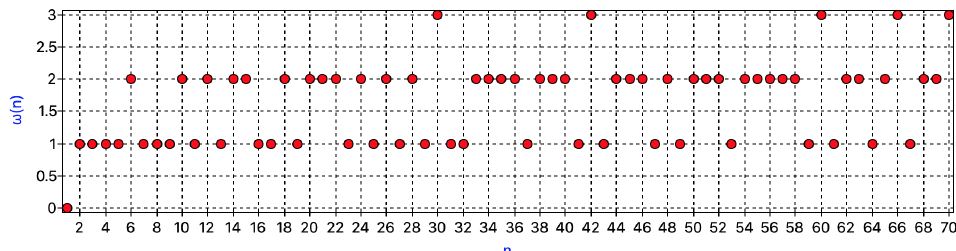
Figure 3. The simulation for ω ( n ) with 1 ≤ n ≤